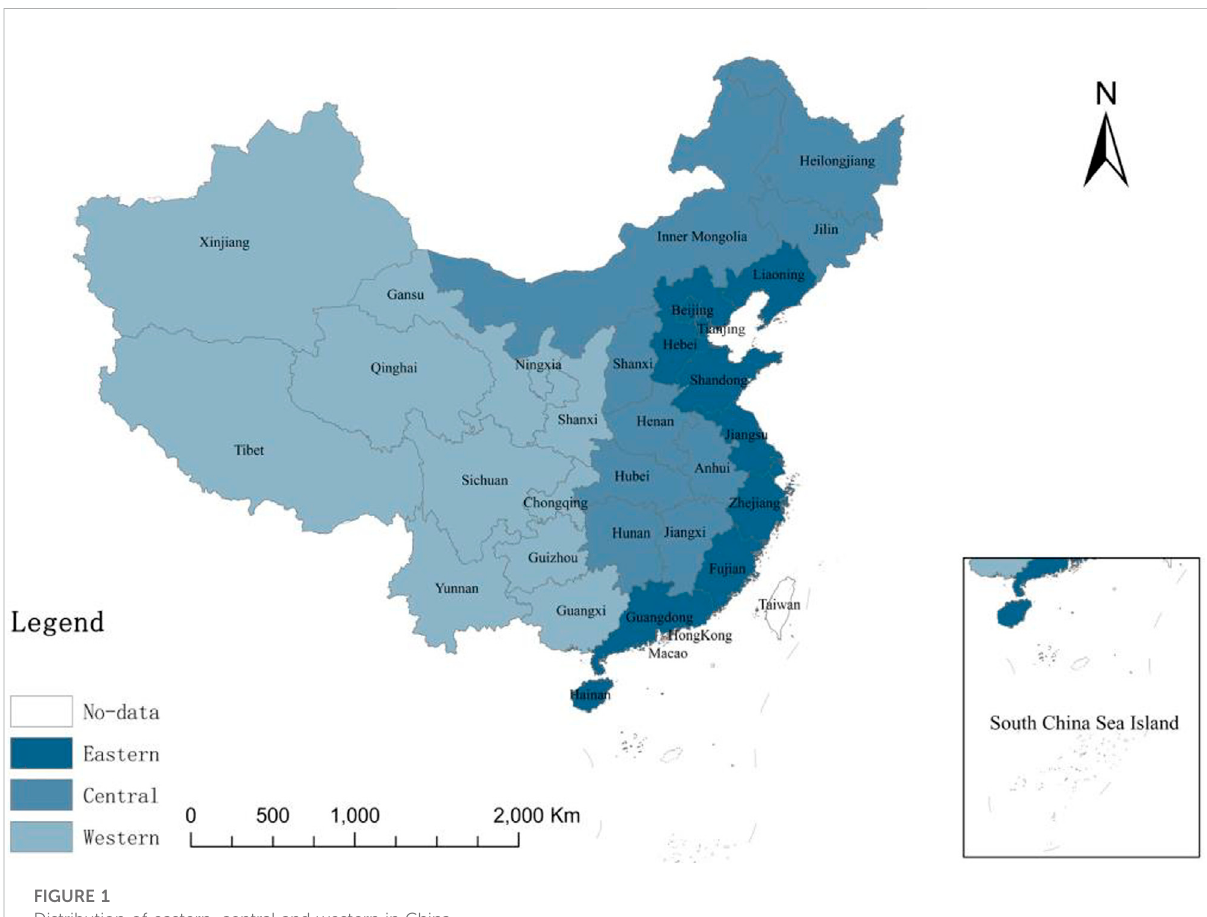
FIGURE 1 Distribution of eastern, central and western in China.